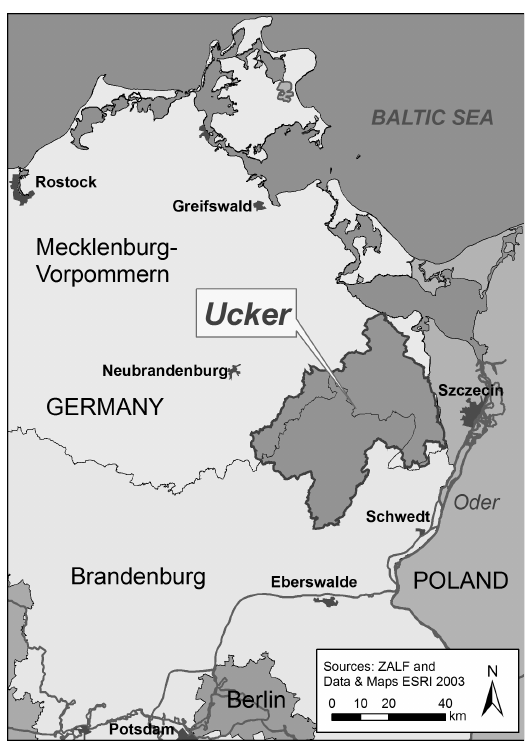
Fig. 1. Location of the Ucker catchment in NE-Germany (from Wegehenkel et al.,